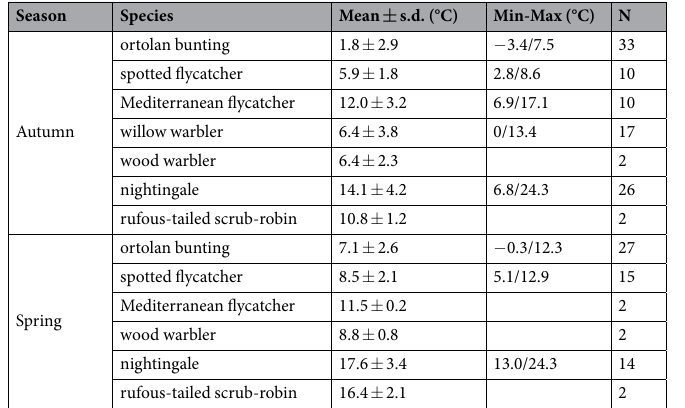
Table 1. Temperature differentials between consecutive days with and without prolonged nocturnal flights while desert crossing, per species and season. Min and Max values reported here are the minimal and maximal estimated temperature differentials. Sample size refers to the number of day